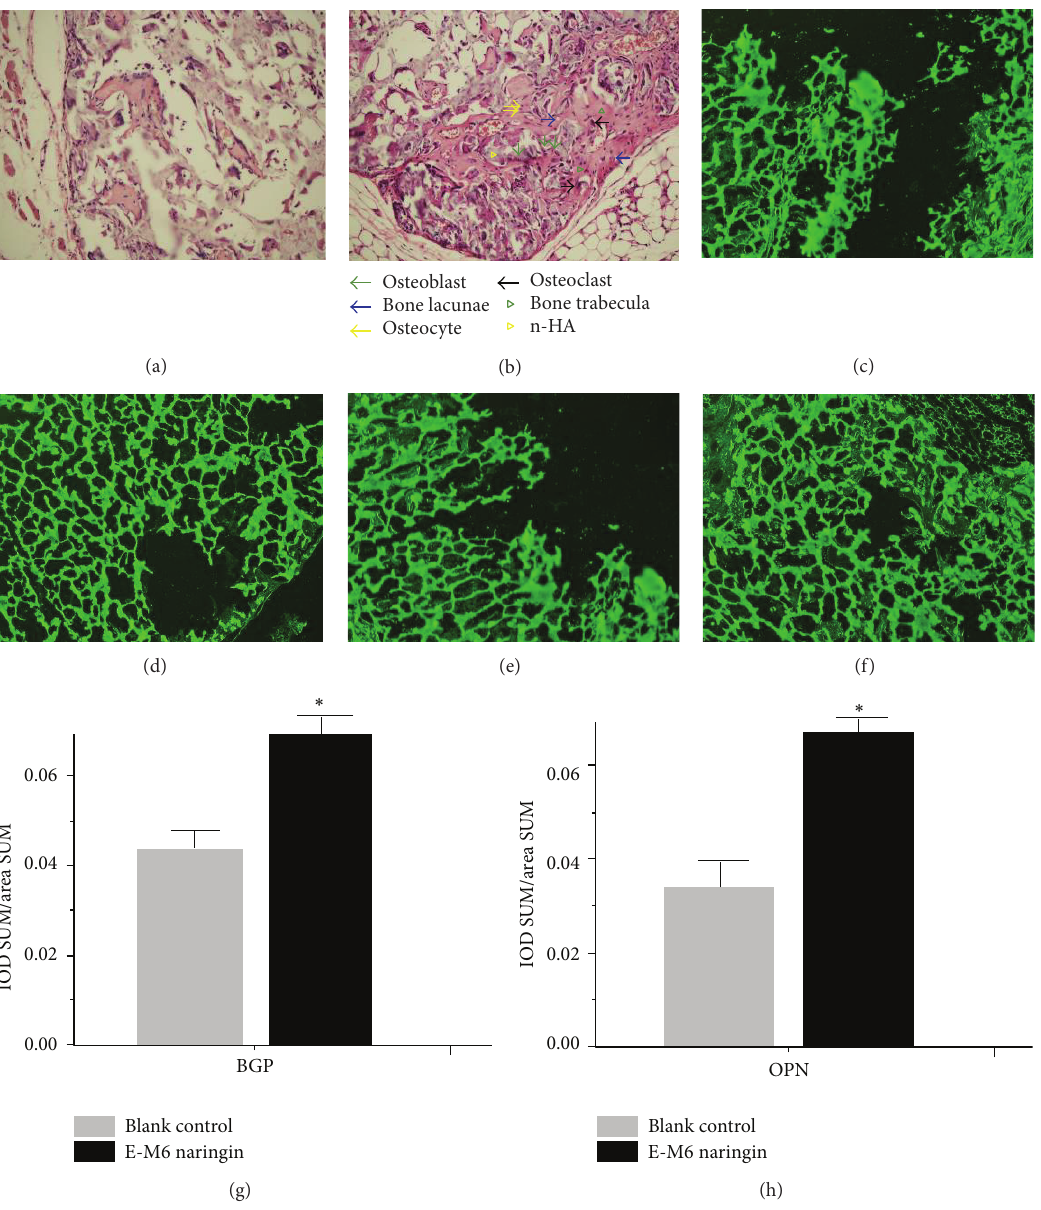
Figure 9: (a) Newly formed bone and dense connective tissue around the nanohydroxyapatite in the control group ( × 100), (b) in naringin 1 𝜇 M group, newly formed bone and dense connective tissue around the nanohydroxyapatite ( × 100), (c) FITC fluorescence expression of BGP in the control group ( × 100), (d) in naringin 1 𝜇 M group, FITC fluorescence expression of BGP ( × 100), (e) FITC fluorescence expression of OPN in the control group ( × 100), (f) in naringin 1 𝜇 M group, FITC fluorescence expression of OPN ( × 100), (g) average optical density IOD SUM/area SUM of BGP, and (h) average optical density IOD SUM/area SUM of OPN. Data were presented as the mean ± SD ( 𝑁 = 6 ). ∗ is compared with control group, 𝑃 < 0.05